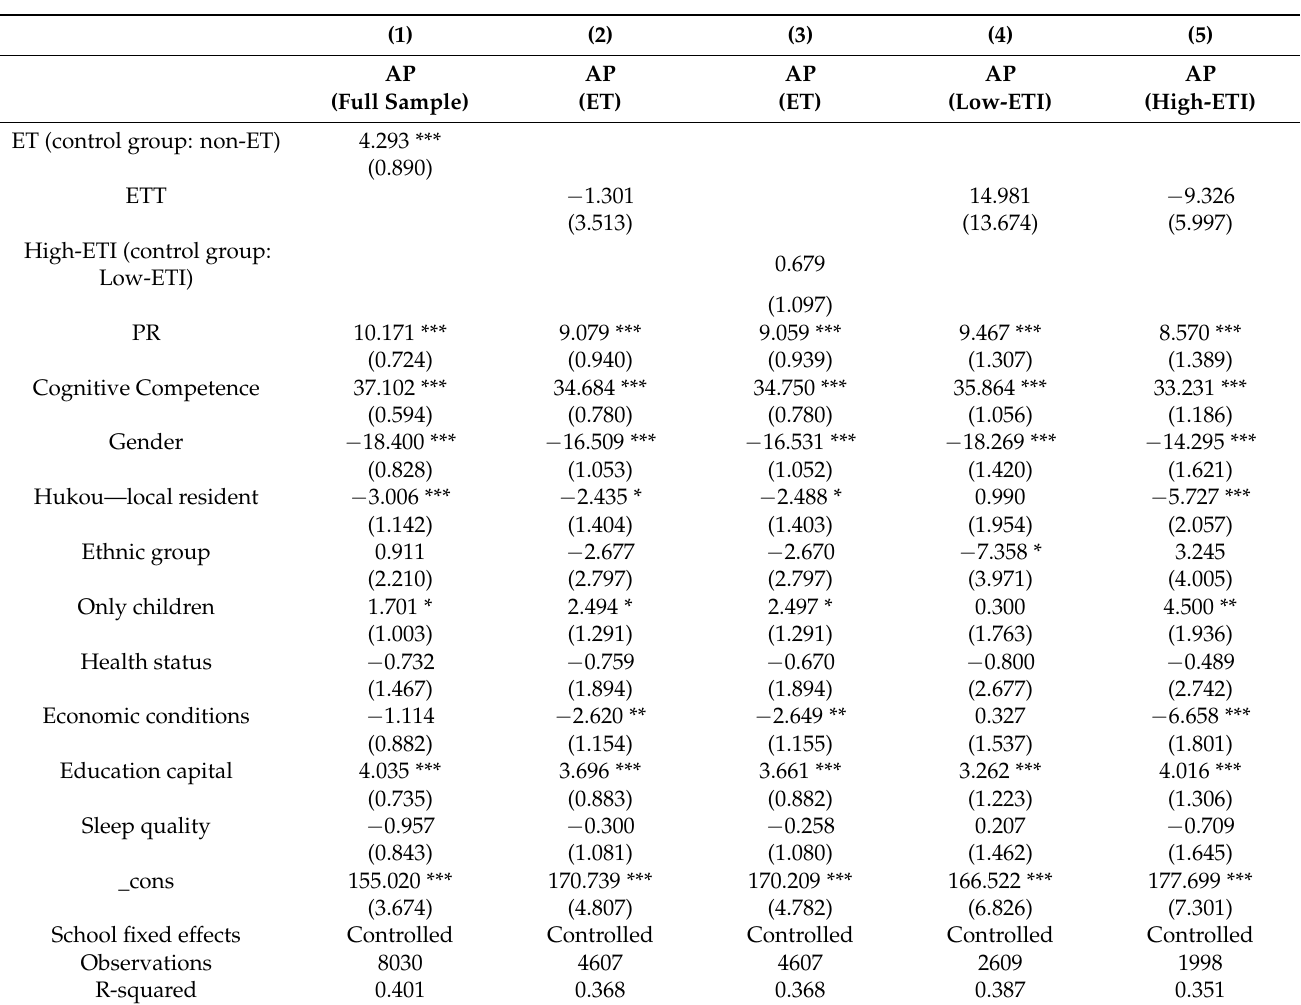
Table 3. ET-AP regression